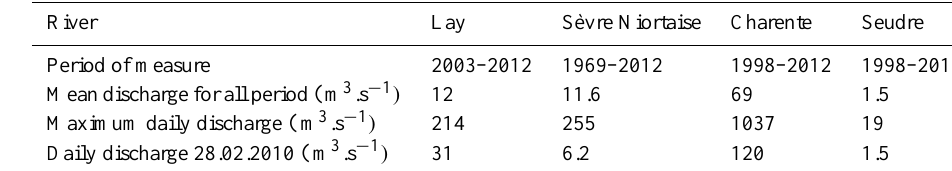
Table 2. Mean, maximum and daily for the day of Xynthia discharges of the four main rivers of the study area. River